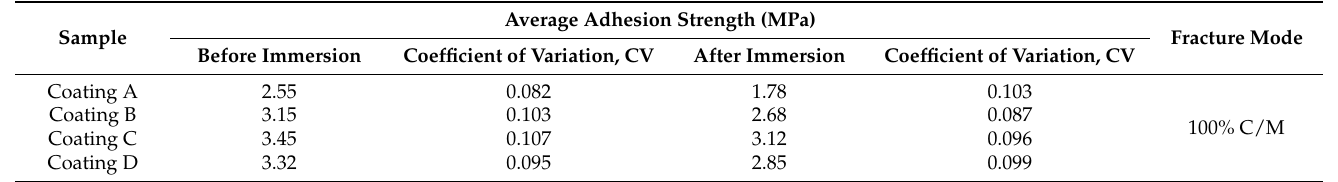
Table 4. The effects of GLYMO on adhesion strength of the silicone-epoxy coatings.